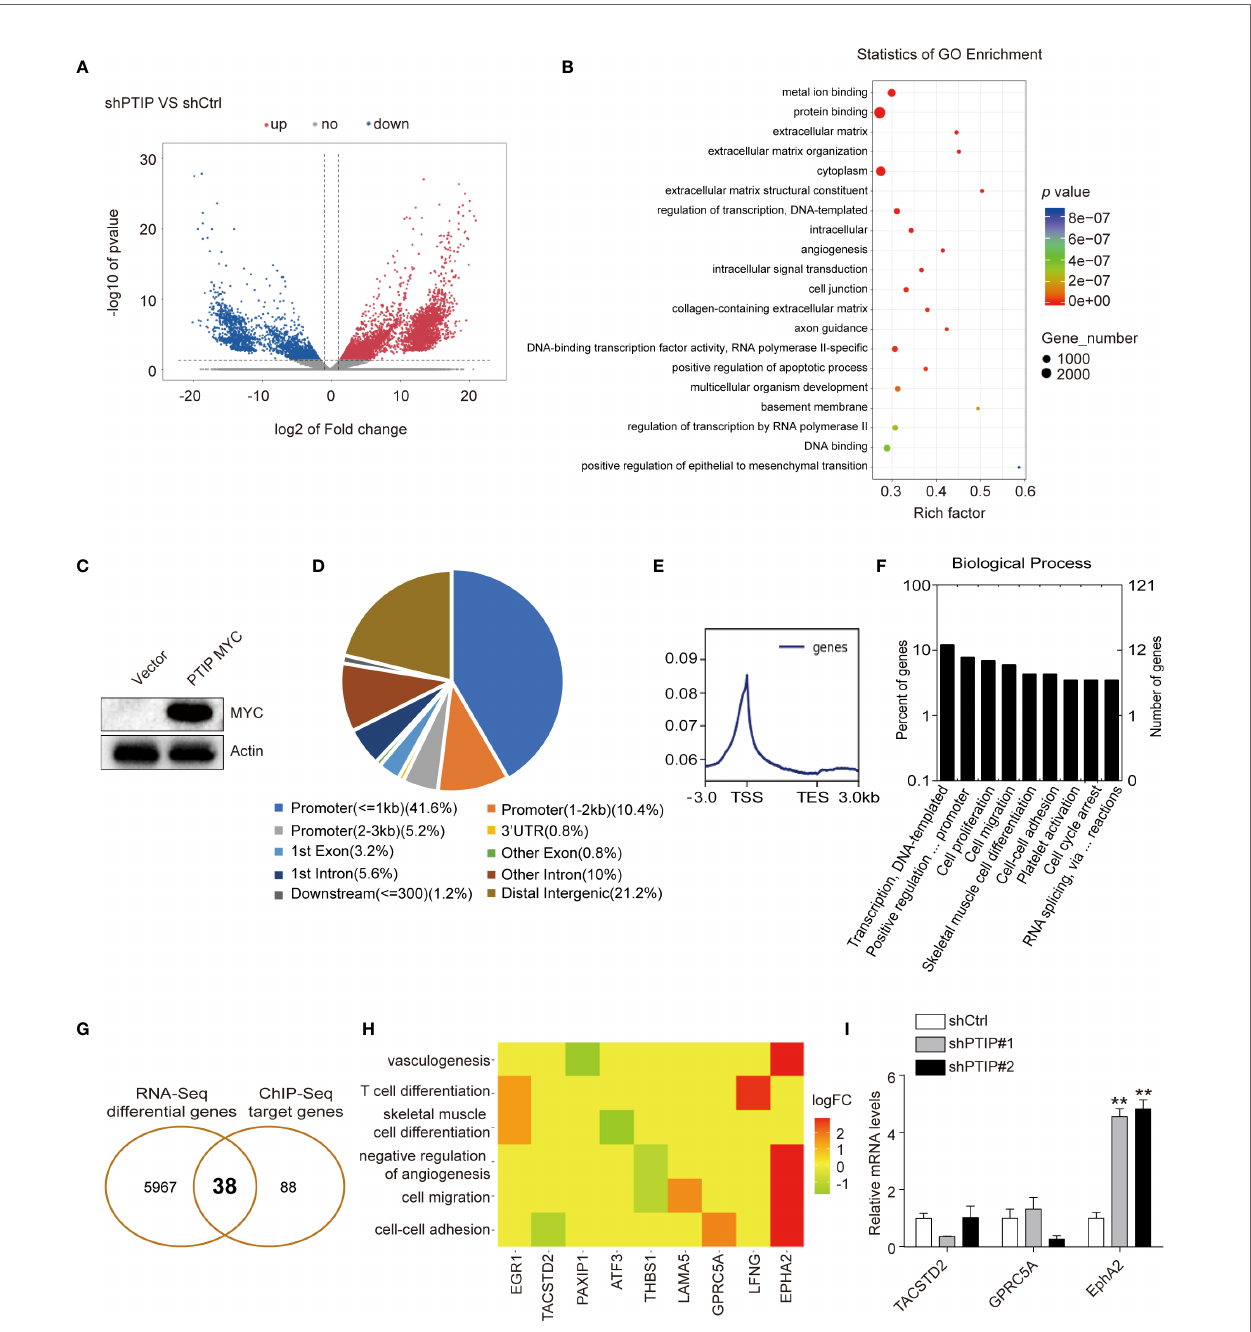
FIGURE 4 | Analysis of the differentially expressed genes(DEGs) and PTIP binding sites. (A) The differentially expressed genes between PTIP knockdown(shPTIP) and control (shScrambled) group were identi fi ed by RNA-seq analysis. Volcano plot shows the log2 fold change (x-axis) and signi fi cance ( − log10 * adjusted p-value; y-axis) with signi fi cantly downregulated and upregulated genes shown in blue and red, respectively (adjust P < 0.01 and |log2Foldchange| < 1). (B) Gene ontology (GO) analysis for enrichment of the DEGs based on the results from (A) RNA sequencing. (C) Western blot veri fi cation of MYC tagged PTIP over-expression ef fi ciency in TE1 cells. (D – F) PTIP binding sites and target genes were identi fi cated by chromatin immunoprecipitation (ChIP)-Seq using MYC tag antibody in MYC tagged PTIP ESCC cell line. Pie charts showing the distribution of PTIP-binding sites in the genome. The percentage of binding sites are indicated in parentheses. The graphs were generated using the ChIPseeker, Deeptools and GOplot package in R. Binding pro fi le around the transcription start site (TSS) of PTIP (E) . Mean read coverage is plotted (y-axis) against a sliding window around the TSS (x-axis). TES, transcription end site; TSS, transcription start site. Enrichment of biological process terms among PTIP target genes (F) . (G) Venn diagram showing the overlapping genes identi fi ed by RNA-Seq data and ChIP-Seq data. (H) Enrichment of biological process terms among the 38 overlapping genes. (I) qRT-PCR analysis of three potentially PTIP directly regulated cell-cell adhesion genes. Representative images and statistical plots are shown; Mean ± s.d. are given for three independent experiments. One-way ANOVA; ** P <